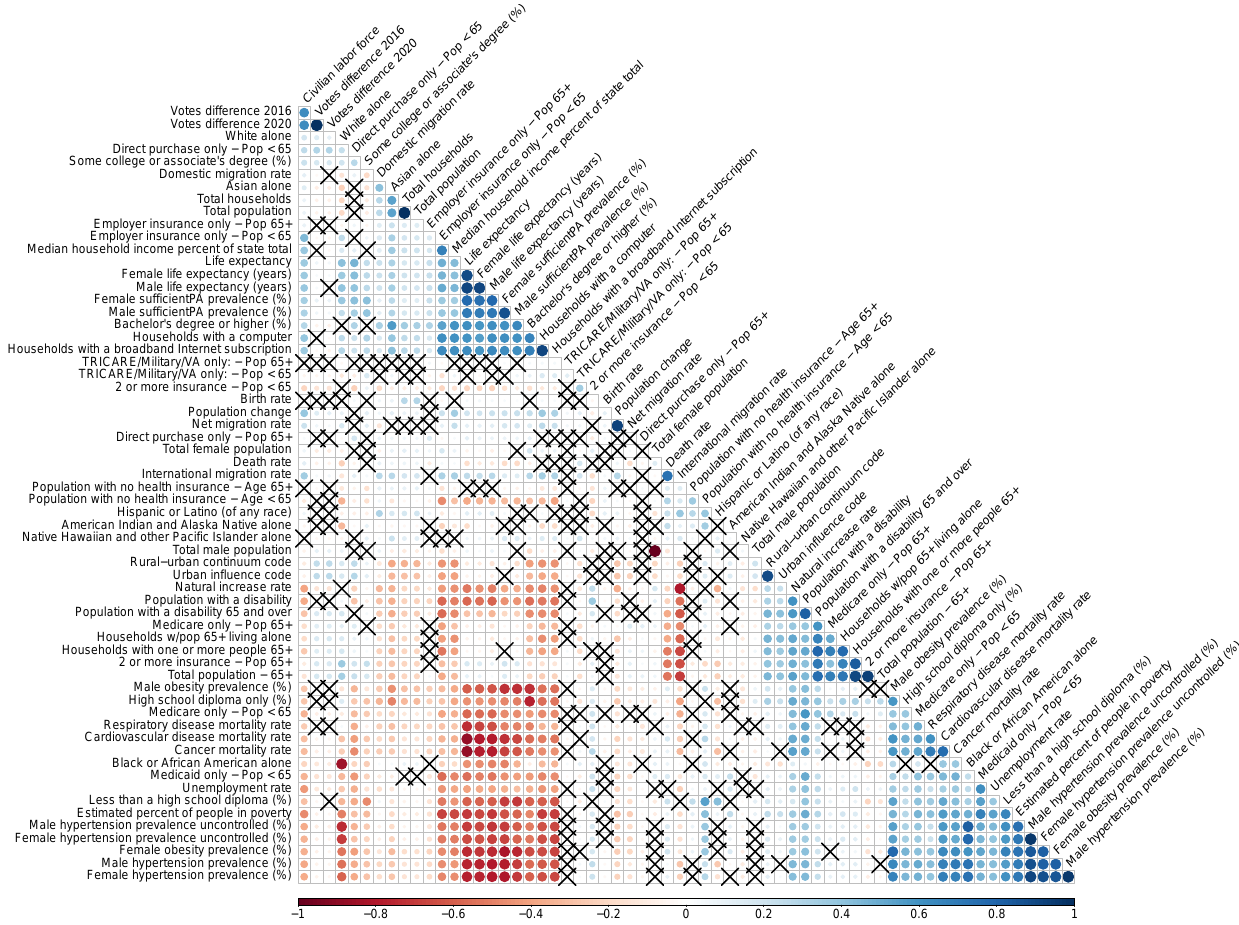
Figure 3. Correlation matrix of the spatial features used in the SGP model. Blue indicates positive correlation, red indicates negative correlation, and cross indicates no correlation. Shade indicates strength of correlation per scale shown at bottom of